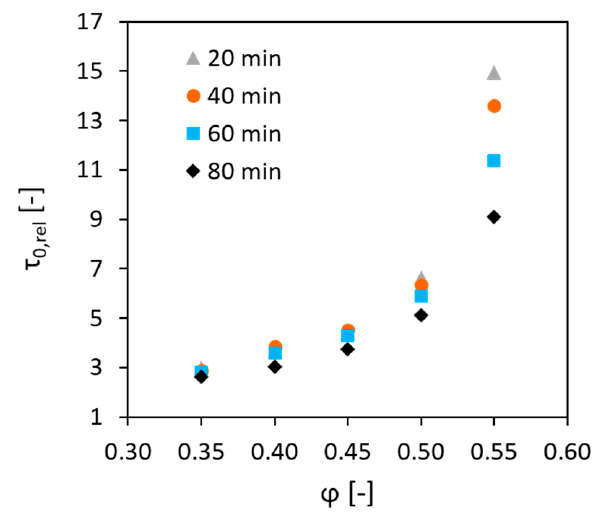
Figure 4. Time-dependency of the development of relative static yield stress with increase in the volume fraction of aggregates in concrete.